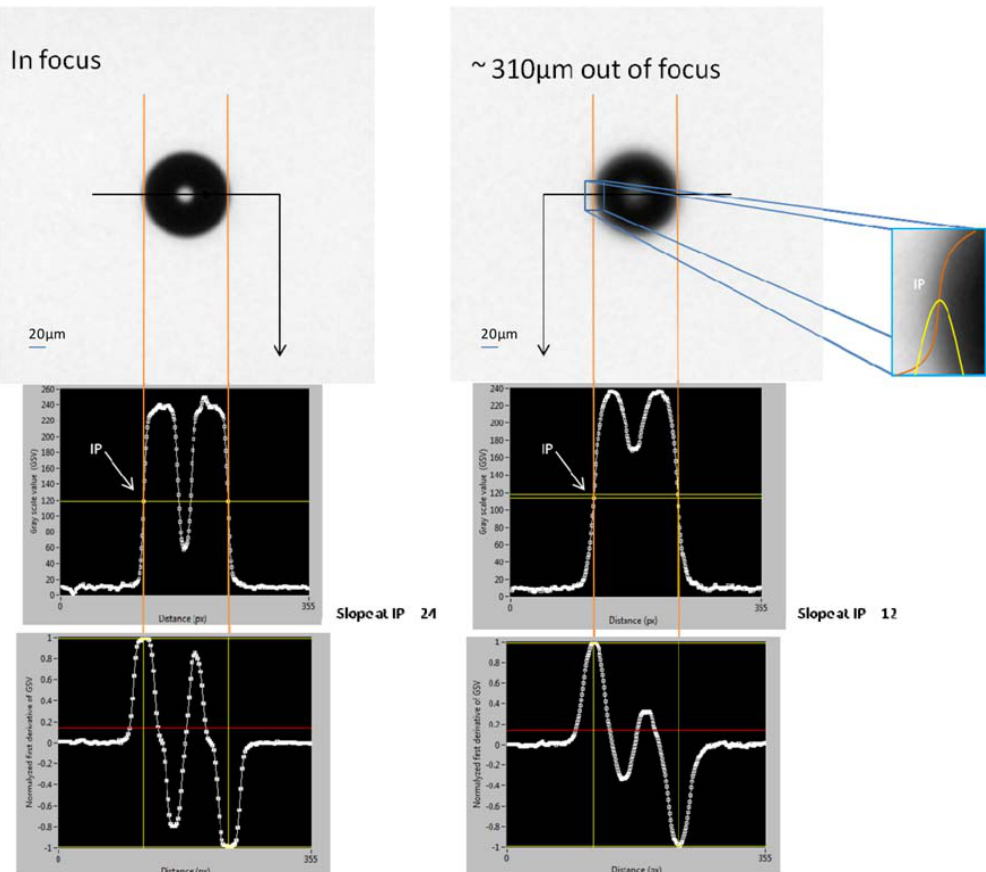
Fig. 4. Gray scale variation at the edge of a spherical particle (a 94µm water droplet) placed in focus (left panel) and 310µm out of focus (rightpanel) positions within the field of view of the PHIPS camera objective. The two upper graphs represent the gray scale values versus distance. The two lower graphs represent the normalized partial derivatives of gray scale values versus distance in pixel unit on the CCD chip. Distances are measured in pixel with respect to an arbitrary point positioned on the left side of the particle.